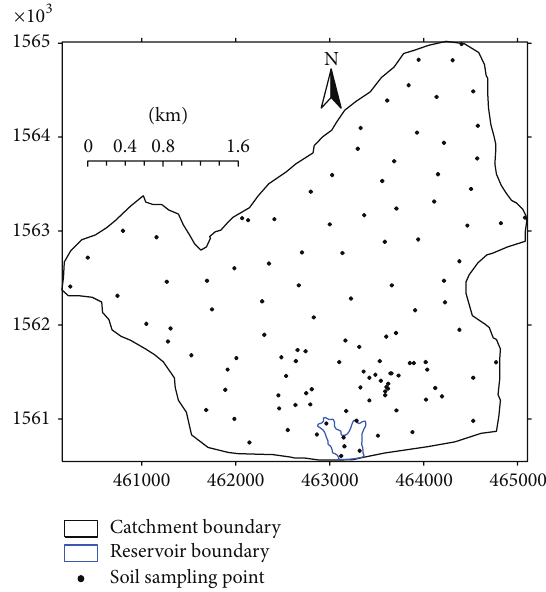
Figure 2: The distribution of soil sampling and vegetation cover points in the study